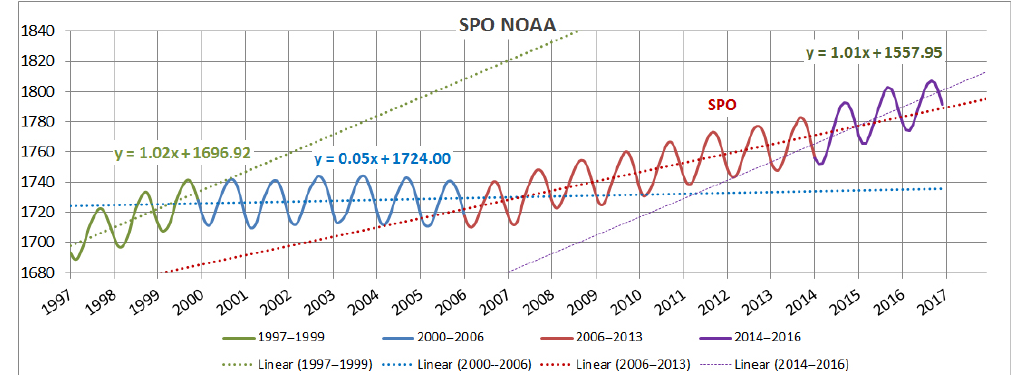
Figure 1. Development of monthly mean CH 4 mixing ratios (nmolmol − 1 ) at the NOAA observation site at the South Pole (SPO, 90 ◦ S) over the years 1997–2016, the period considered in this modeling